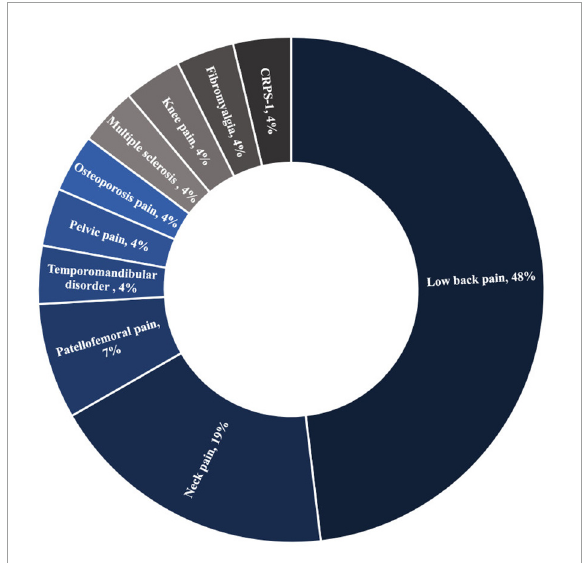
FIGURE3 The relative distribution of chronic pain conditions in RCTs that were included ( n = 27).